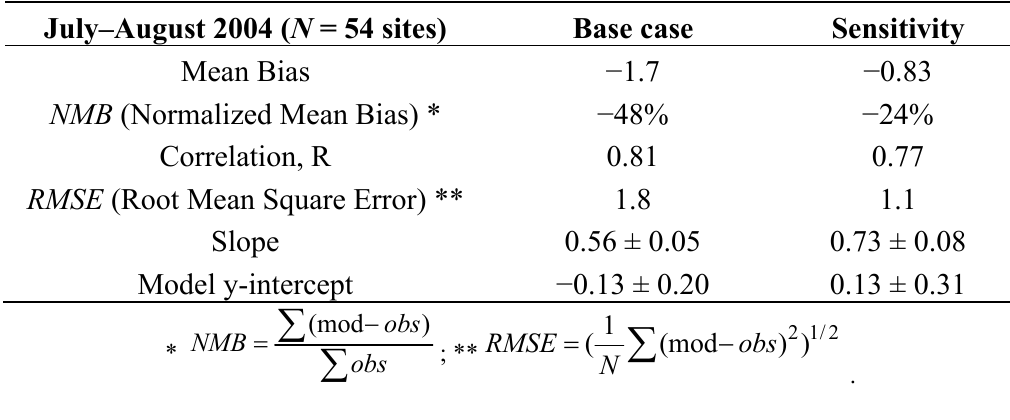
Table 4. AURAMS model comparison (42km grid spacing) with IMPROVE 2004 PM OA data (24-h samples every 3rd day, 2-month average for each